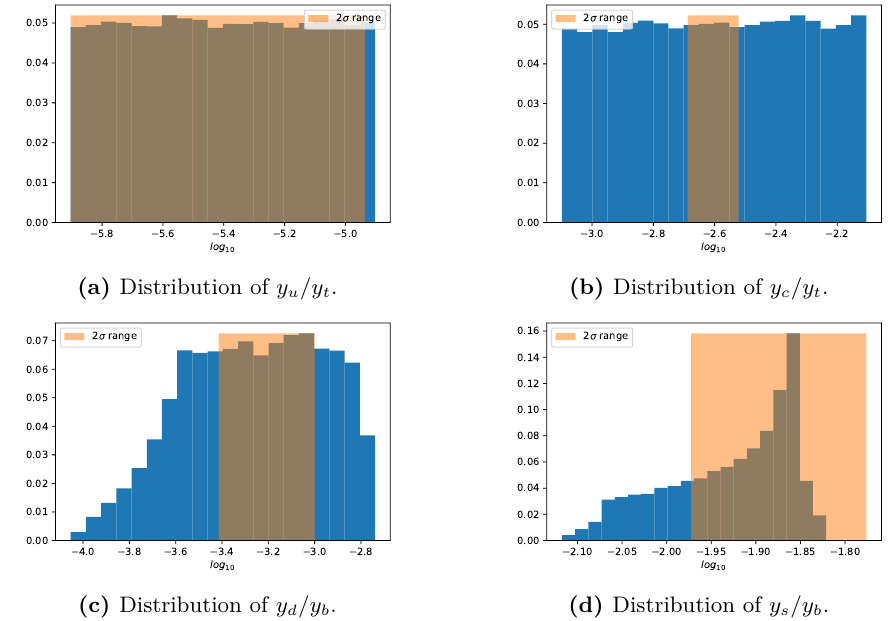
Figure 2. Distribution of the mass ratios. The blue bars denote the distributions of the mass ratios. The distributions have been normalized already. The orange region denotes the 2 σ region of the corresponding